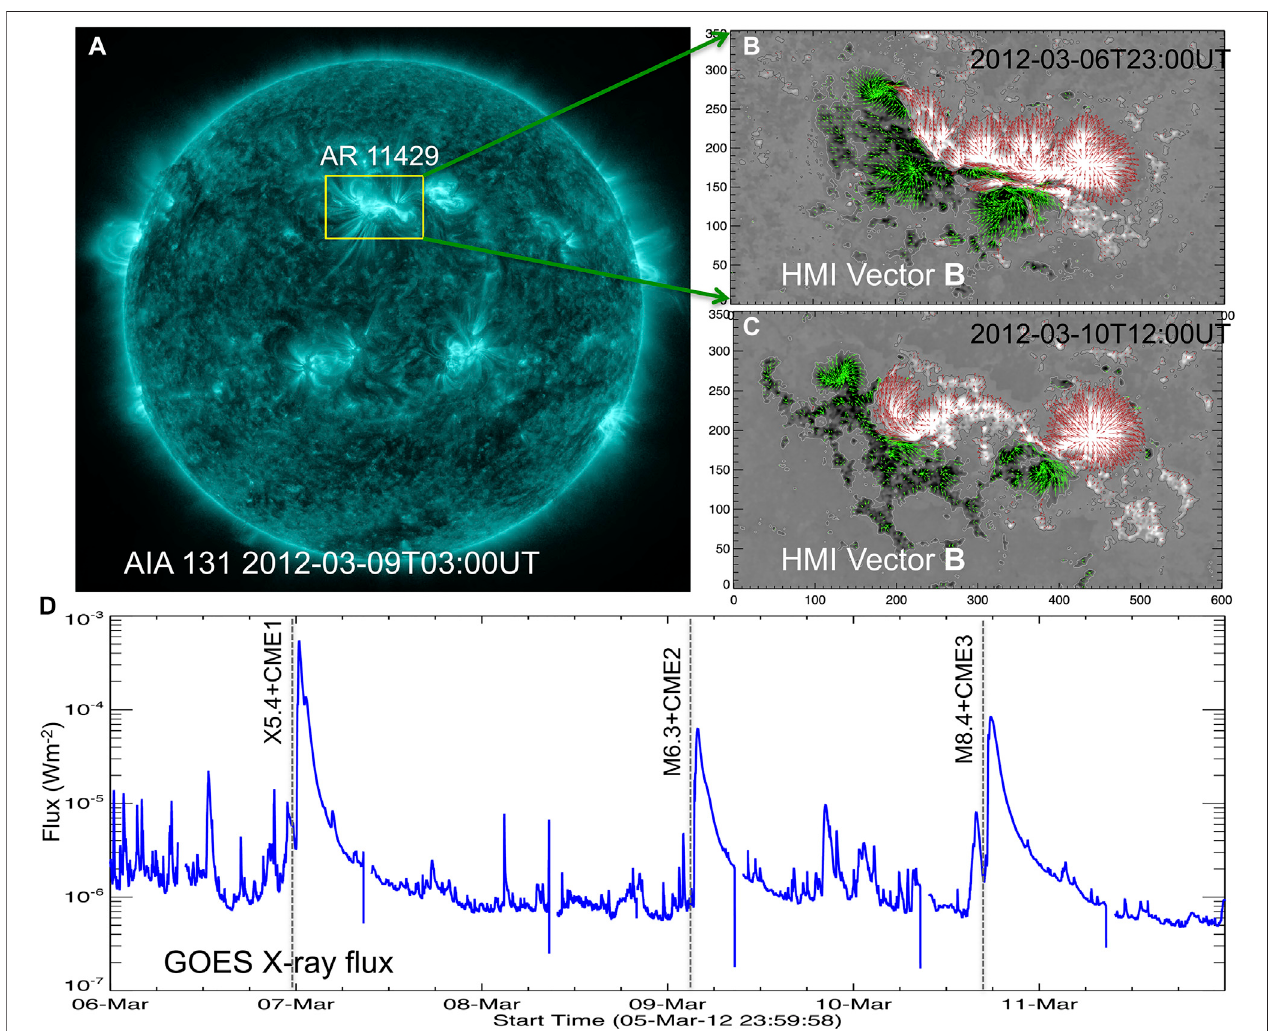
FIGURE 2 | Observations of the successively erupting AR 11429 (A) Full disk observation of AIA 131 Å. The structured emission from AR 11429 is outlined with yellow rectangular box, (B-C) HMI vector magnetogram observations of the AR 11429 at the onset of CME eruptions on March 6 and 10 respectively. The background imageisverticalmagnetic fi eldwithcontoursat ± 120 G.Green/redarrowsdenotehorizontal fi eldwiththeirlengthbeingproportionaltothemagnitude B h (cid:1) Axis units are pixels of 0.5 arc-second, (D) Disk integrated GOES X-ray fl ux in 1 – 8 Å band during the disk transit time of the AR 11429. Text near the X-rays peaks refers to the CMEs and associated X, M-class fl ares from the AR